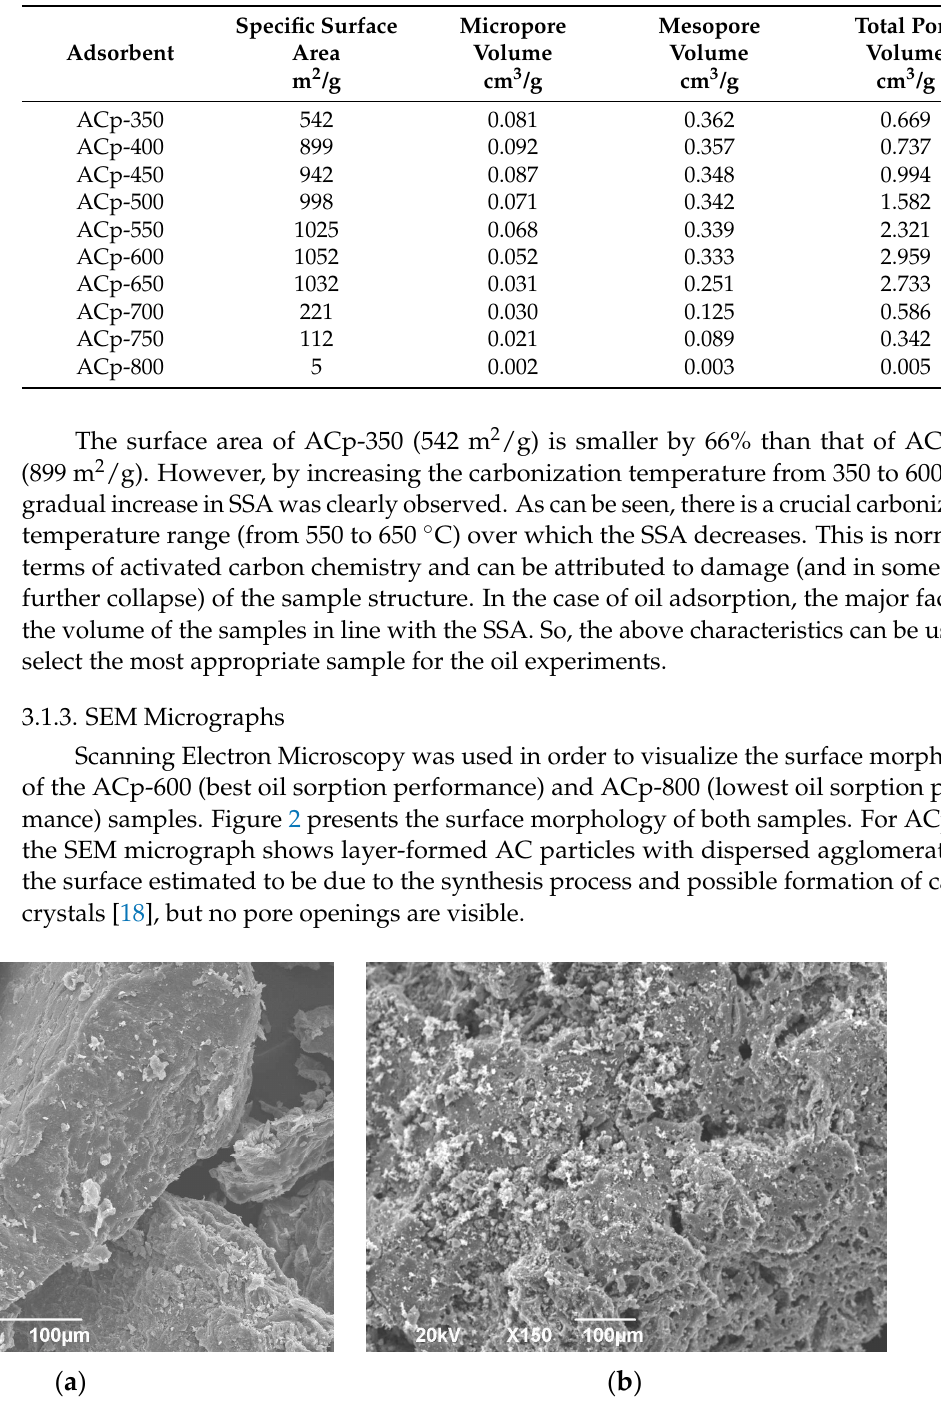
Figure 2. SEM micrographs; ( a ) ACp-800 and ( b )